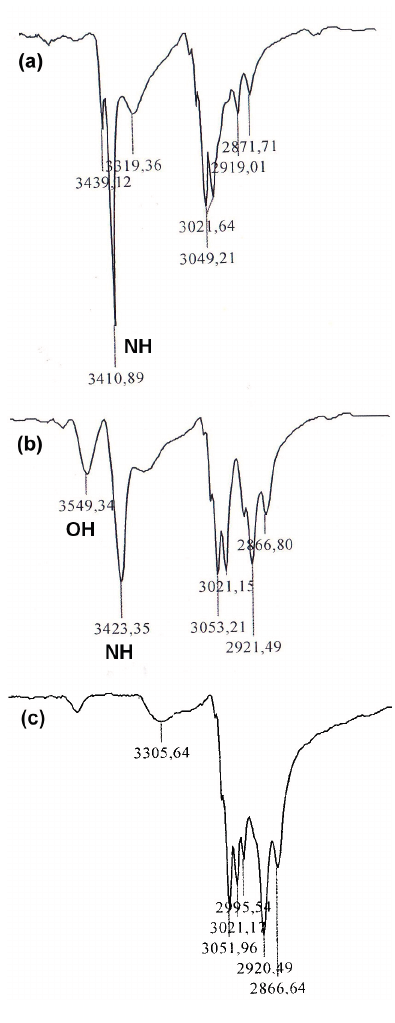
Figure 1. Fragments of the IR spectra of epoxide 2 ( a ), dimer 3 ( b ) and DPEC ( c